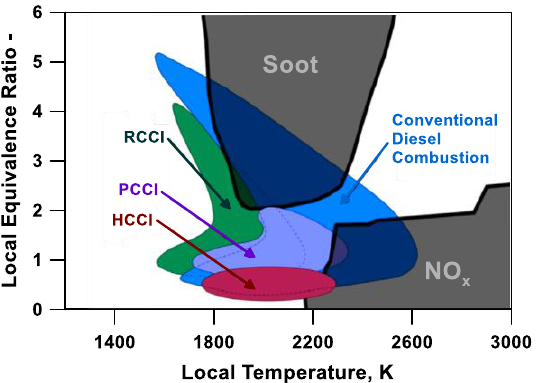
Figure 1. Conventional compression ignition and low temperature combustion regimes in Φ -T diagram